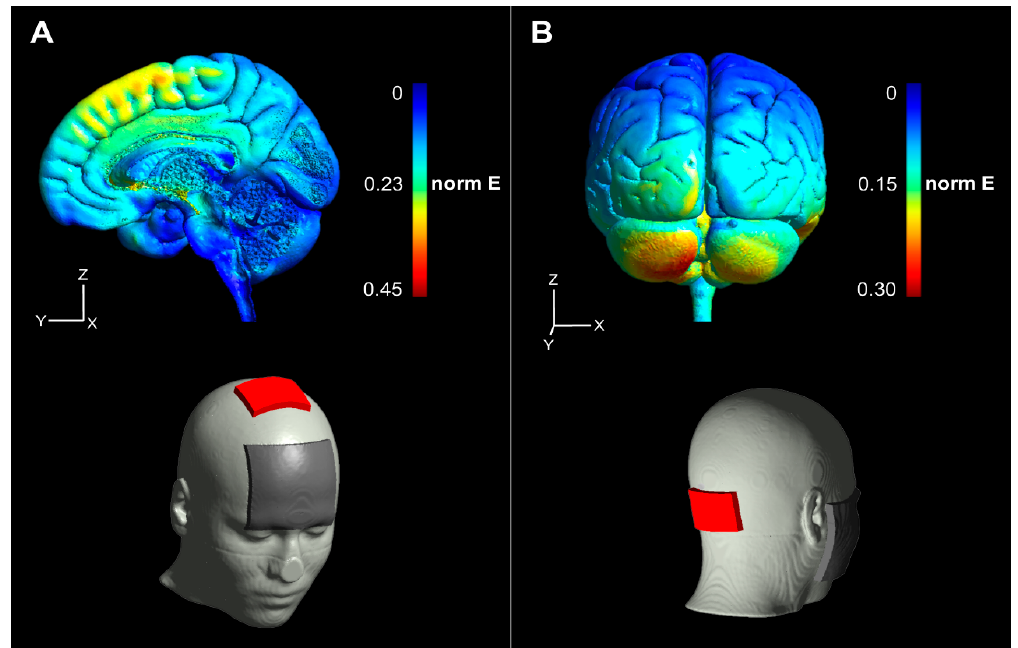
Figure 2. Transcranial direct current stimulation (tDCS) current flow simulation. Simulated current flow is illustrated for primary motor cortex (M1)-tDCS ( A ) as well as cerebellar (CB)-tDCS ( B ). Anodes are depicted as red rectangles and cathodes as gray rectangles projected on a standard head model in the lower half of ( A ) and ( B ), respectively. Normalized electrical field strength (V / m) is indicated through colormaps with blue representing lowest and red representing highest field strengths, respectively.